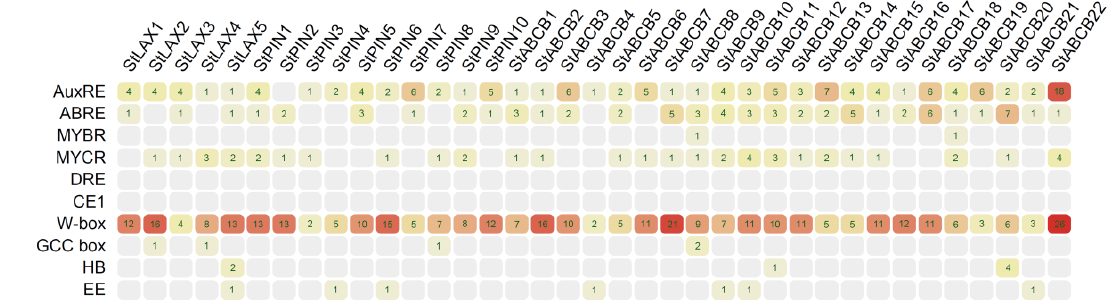
Figure 9. Analysis of auxin − responsive and stress − related cis − regulatory elements in the 2 kb promoter regions of StLAX, StPIN, and StABCB genes.